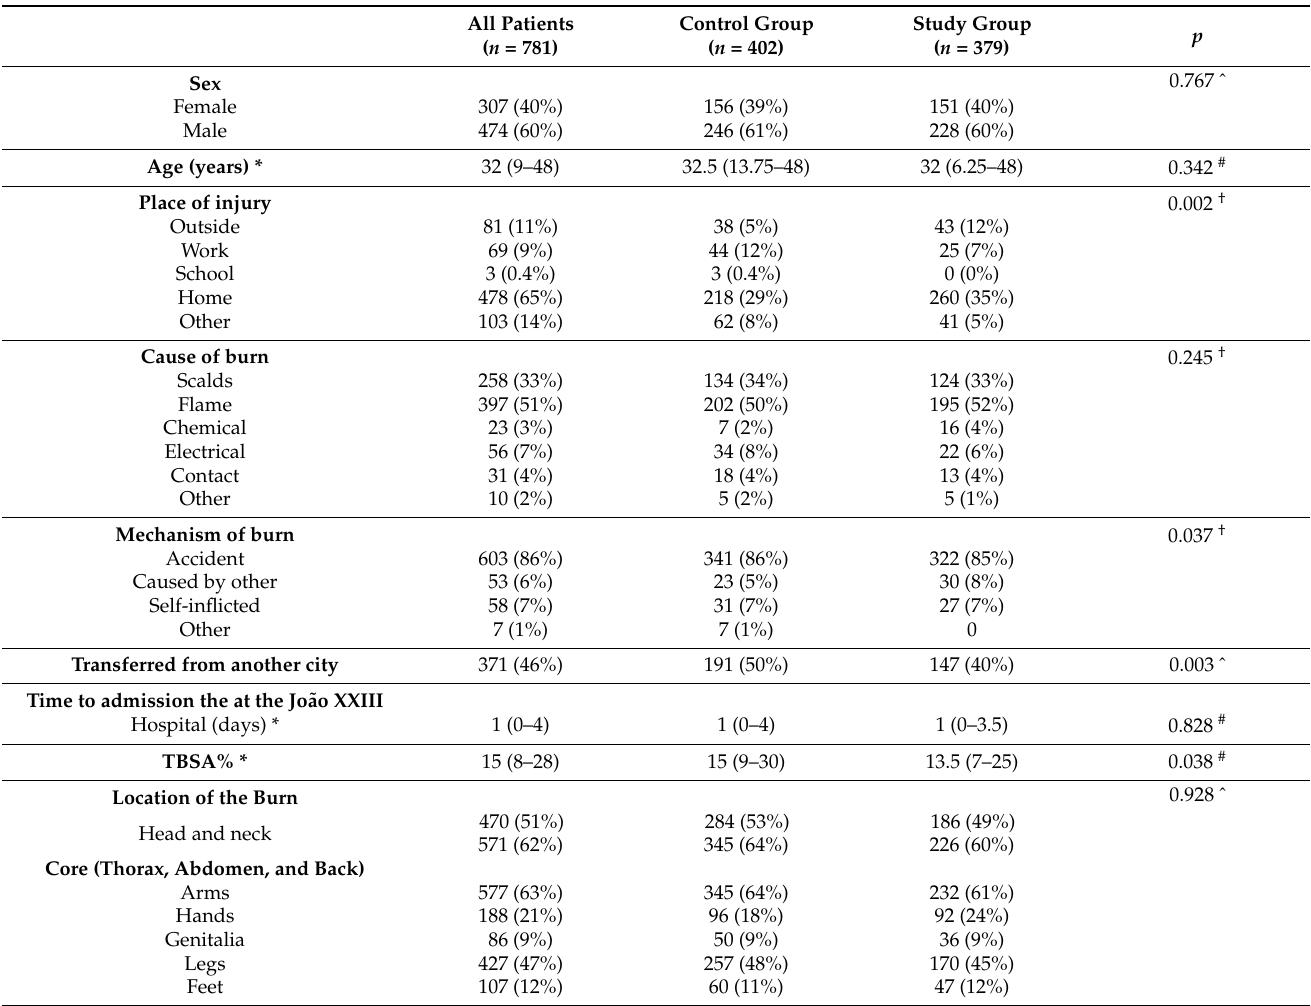
Table 1. Comparison between the study and control